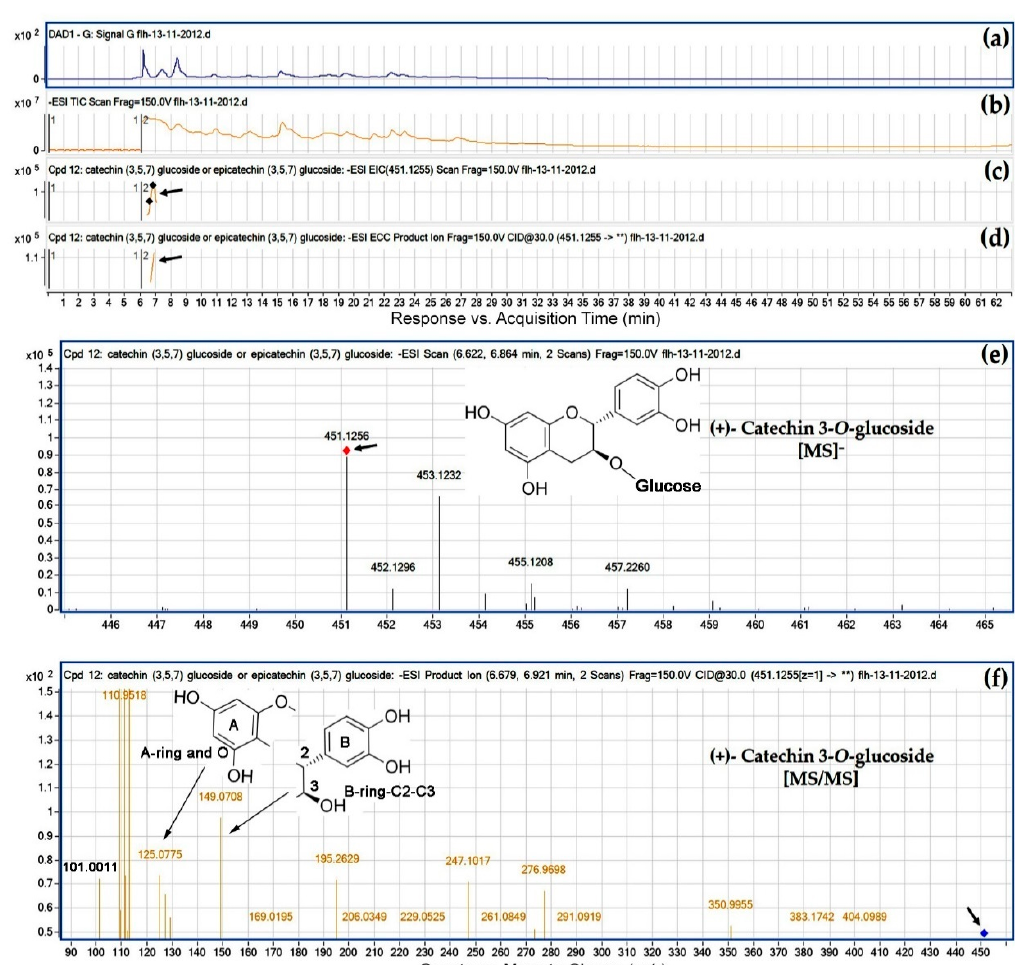
Figure 5. Extracted ion chromatogram (EIC) of primary mass spectrum (MS1) and m / z features of secondary ion fragments (MS2) derived from LC-MC/MS annotate this peak to be (+)-catechin 3- O -glucoside (MW, 452.41). ( a ) Chromatogram of FLH 13-11 extracts (2012) recorded at 280 nm; ( b ) total ion chromatogram of FLH 13-11 extracts (2012); ( c ) EIC of primary ion 451.1255 [M − H]¯; ( d ) enhanced charge capacity (ECC) ion product for m / z 451.1255; ( e ) a MS profile showing an extracted m / z value, 451.1256 and ( f ) fragments from collision-induced dissociation (CID) of m / z 451.1256 showing m / z 109.0471, 110.9518, 125.0775, 149.0708, 169.0195, and 247.1017 (Table 1).